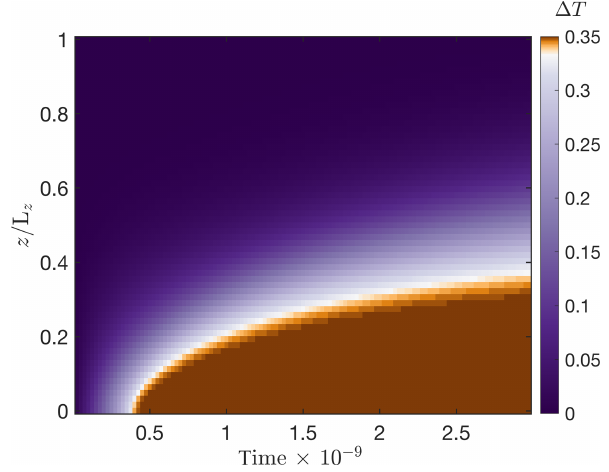
Figure 14. Experiment 3 includes a phase transition owing to melt- ing. We report the evolution in time of non-dimensional temperature variation (cid:49)T along a vertical profile picked at location x = L x / 2 within a 2-D run from Experiment 3. For this purpose, we run the 2-D FastICE models from Experiment 3 for a duration of 2 . 9 × 10 9 .